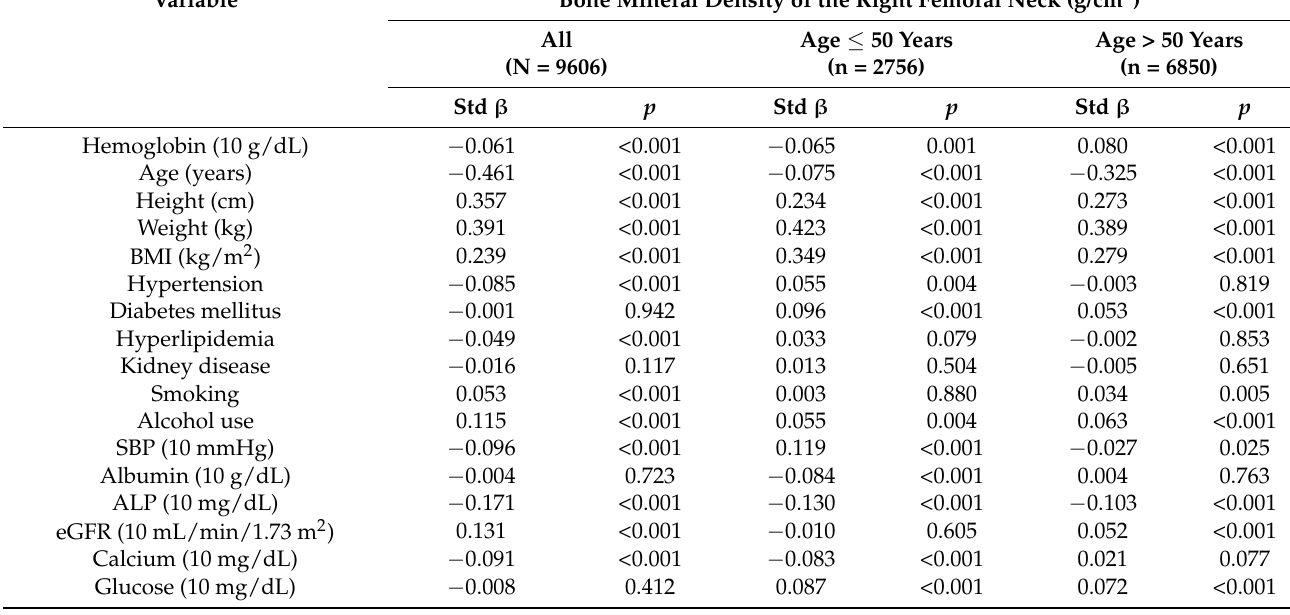
Table 4. Simple linear regression analysis of factors associated with bone mineral density of the right femoral neck in all female patients and those stratified by